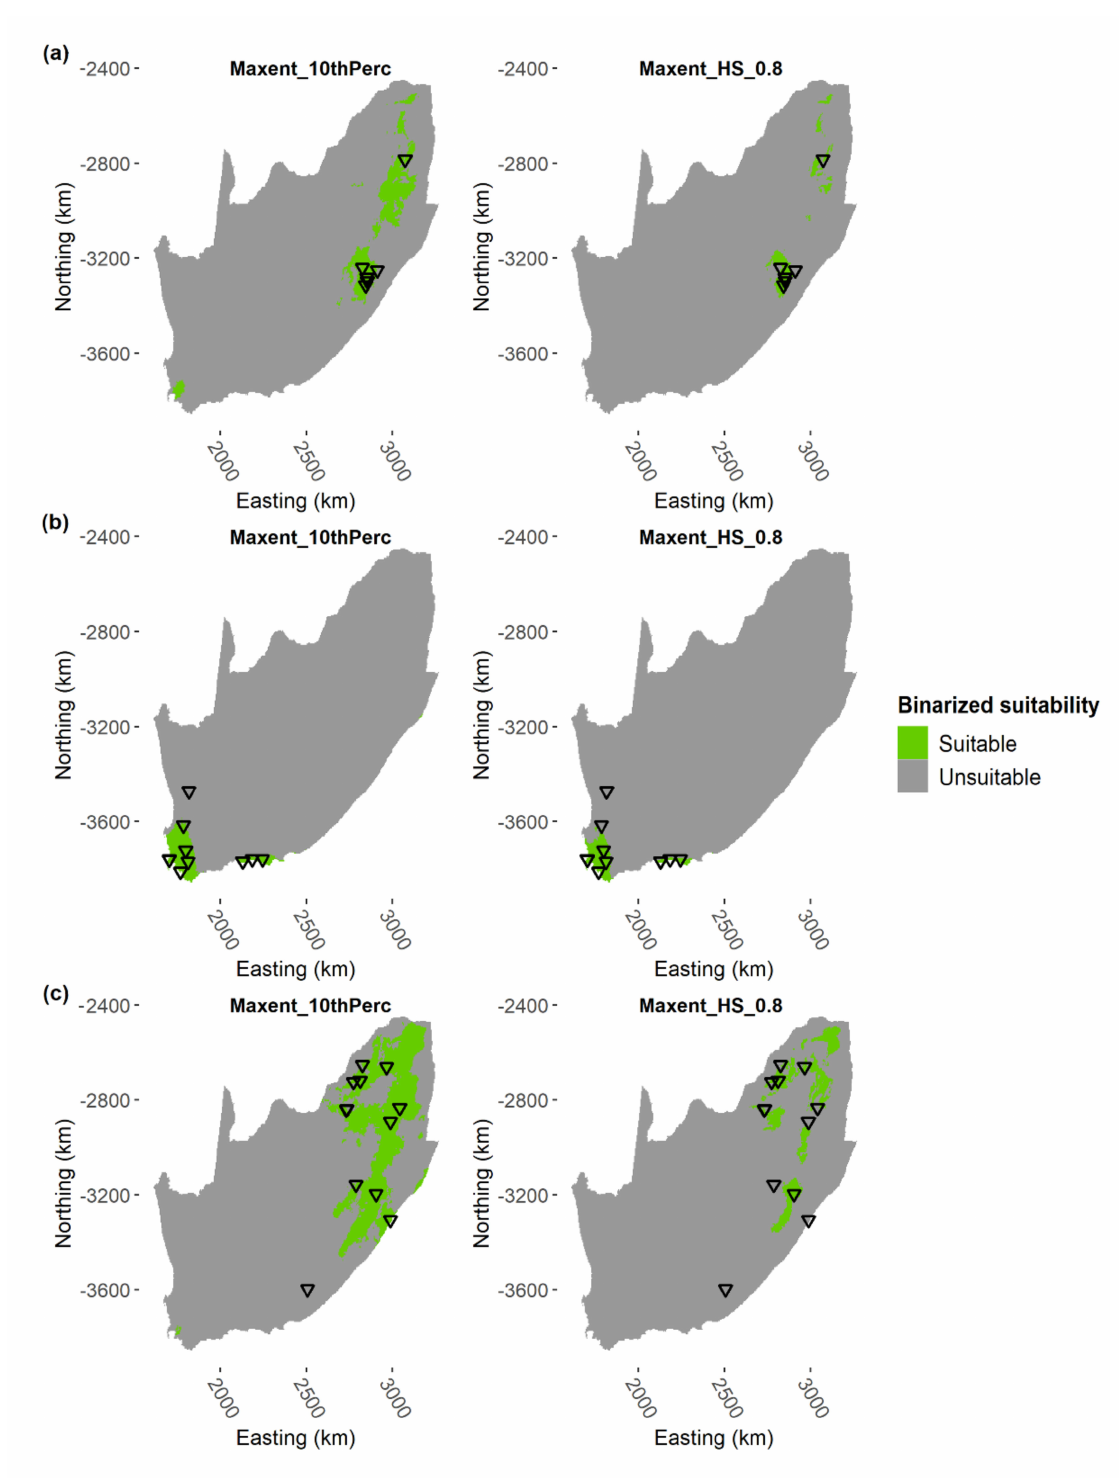
Figure 6. Binarized suitability resulting from the conversion of the Maxent-derived weighted av- erage habitat suitability (Wgt_Avg HS) to binary predictions based on the 10th percentile training threshold (left maps) or on a threshold corresponding to Wgt_Avg HS ≥ 0.8 (right maps), for: ( a ) Chaetocnema brincki ; ( b ) C. danielssoni ; ( c ) C. gahani . Reversed black-contoured triangles indicate the species’ occurrence